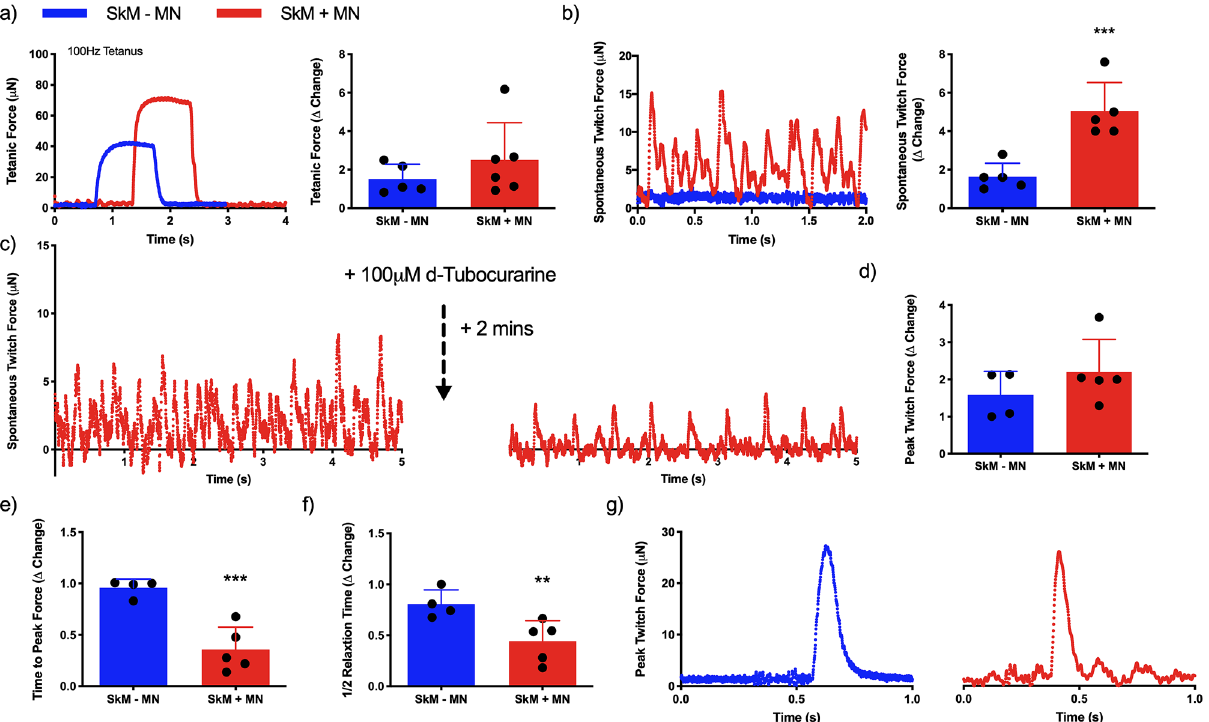
Figure 7. Physiological functionality of engineered tissues is enhanced via neuromuscular junction formation. ( a ) Representative maximal induced tetanus contraction profiles of muscle (SkM -MN) and neuromuscular tissue (SkM + MN) and quantification of tetanic force. ( b ) Spontaneously occurring twitch force profiles in engineered tissues with (SkM + MN) and without (SkM–MN) iPSC motor neuron spheroids, and quantification of spontaneous twitch force driven via motor nerve inclusion. ( c ) Inhibition of the acetylcholine receptor in spontaneously contracting neuromuscular tissues via addition of 100 µM d-Tubocurarine. ( d ) Peak twitch force induced via electrical field stimulation. ( e ) Time to peak twitch force and ( f ) half relaxation time as physiological measures of contractile function. ( g ) Representative twitch profiles evidencing reduced time to peak twitch and shorter relaxation profiles in SkM + MN tissues. Δ change indicative of normalised data to SkM–MN. Beginning of representative tetanus and twitch contractions represents initiation of electrical field stimulation, time elapsed before this point is un-stimulated baseline recording. Individual functional data points indicative of n = 3 contraction profiles per tissue, totalling minimum of n = 12 and maximum of n = 18 contractions per condition and presented ± standard deviation (SD). **P ≤ 0.01 and ***P ≤